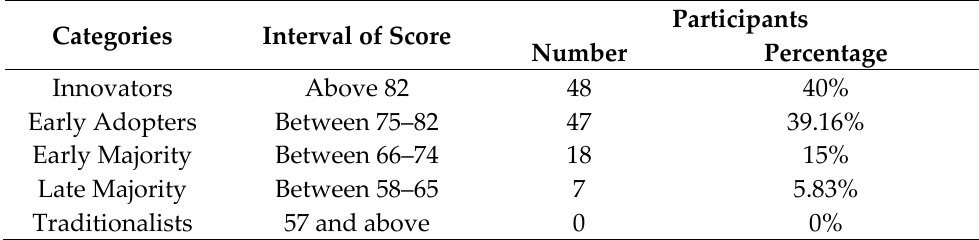
Table 7. Scores of participants and their distribution.